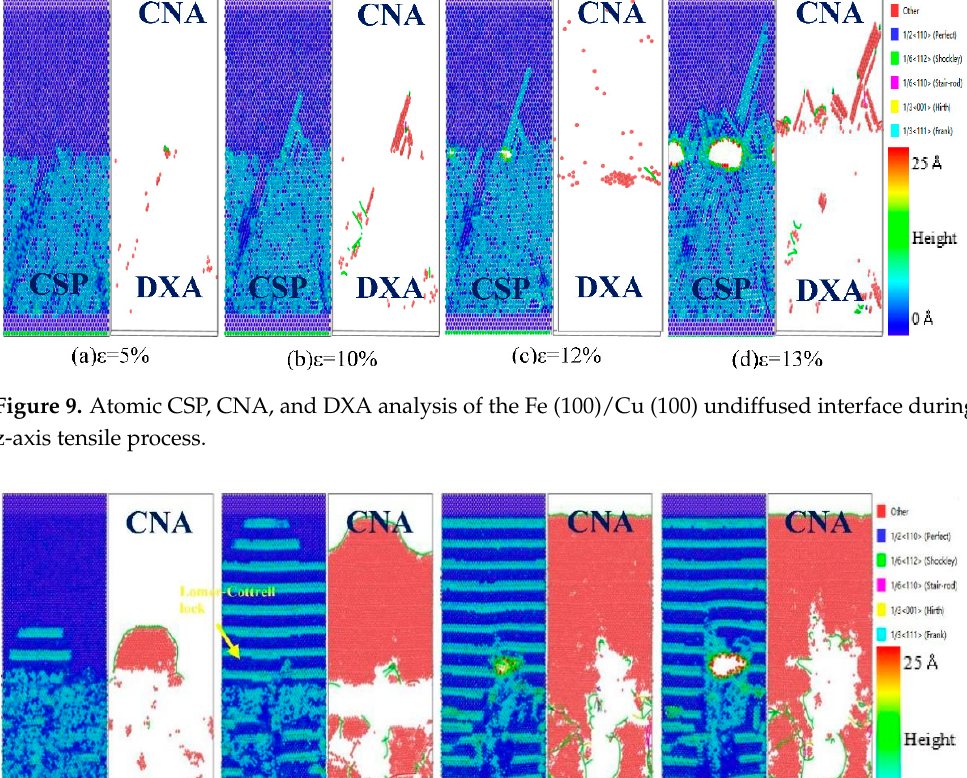
Figure 8. Stress–strain curves of ( a ) Fe (100)/Cu (100) interface at different strain rates from 1 × 10 8 /s to 1 × 10 10 /s; ( b ) Fe (110)/Cu (110) interface at different strain rates from 1 × 10 8 /s to 1 × 10 10 /s; ( c ) Fe (111)/Cu (111) interface at different strain rates from 1 × 10 8 /s to 1 × 10 10 /s; ( d ) the yield strength of three different interface models under different strain rates.